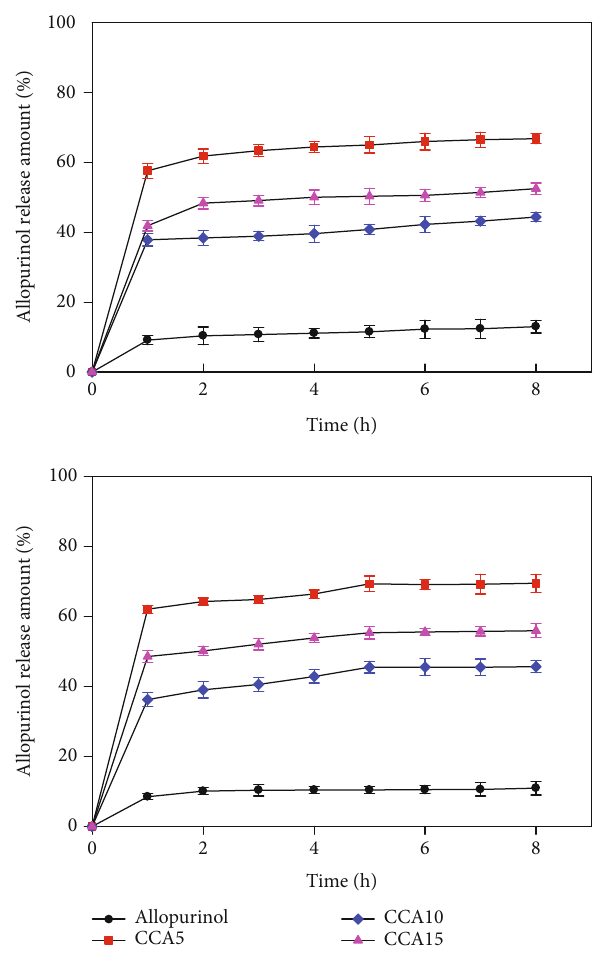
Figure 5: Graphs re fl ecting the amount of allopurinol released from CCA biocomposite fi lms vs. time in pH 2.0 and pH 7.4